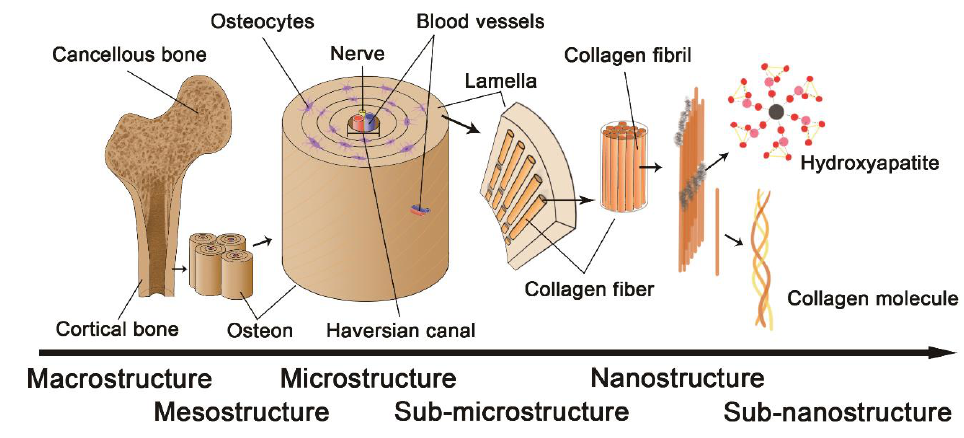
Figure 2. The hierarchical structure of bone.